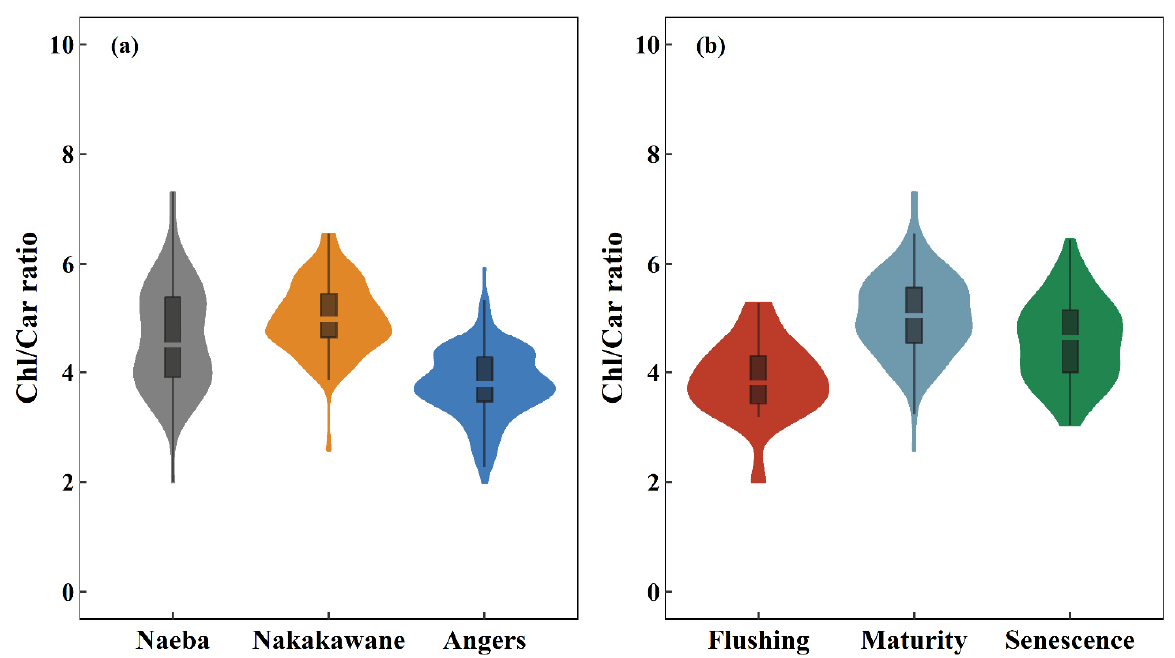
Figure 1. Violin plots with boxplots (inside) for the ratio of chlorophyll (Chl) to carotenoid (Car) (Chl/Car) in different datasets (Naeba, Nakakawane, and Angers) ( a ), and during different phenological stages (flushing, maturity, and senescence) of the Naeba and Nakakawane datasets ( b ). The boxplots indicate the interquartile range (box), median (gap), and 1.5 times the interquartile range (whiskers).